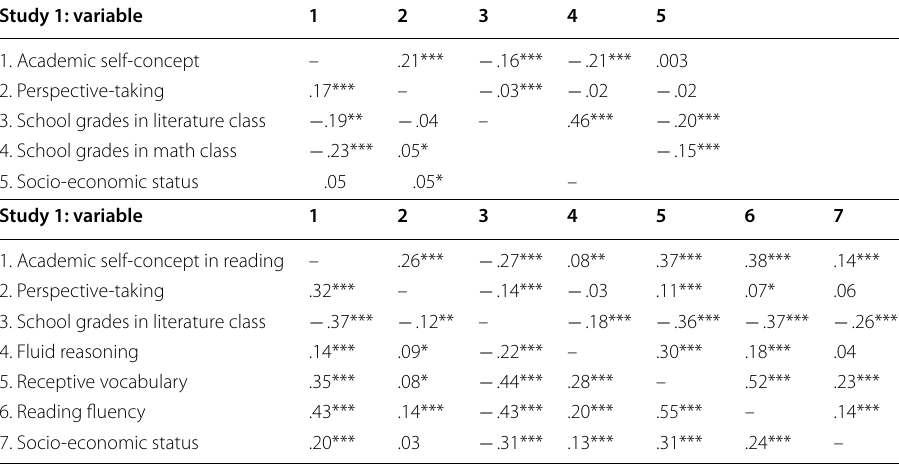
Table 1 Correlations between academic self-concept, perspective-taking, school achievement, cognitive abilities, and socio-economic status at time